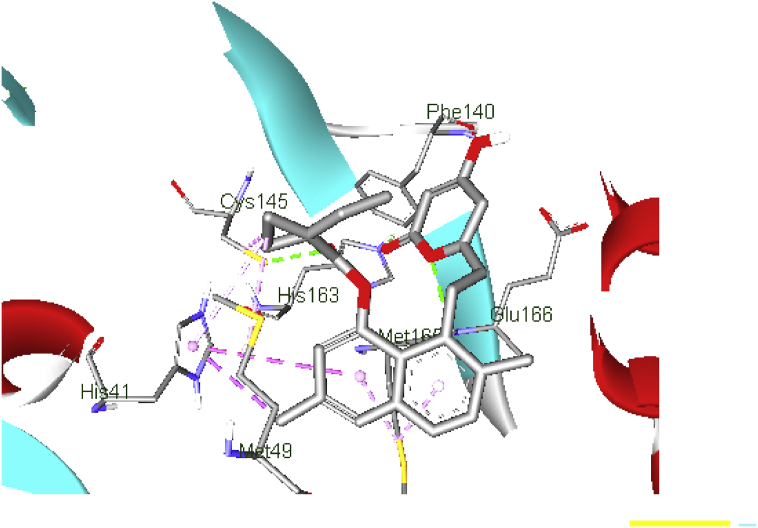
Schematic representation of C19MP (PDB: 6LU7) interactions with simvastatin. Image 1 protein Image 2 ligand Image 3 hydrophobic interaction Image 11 hydrogen bond.